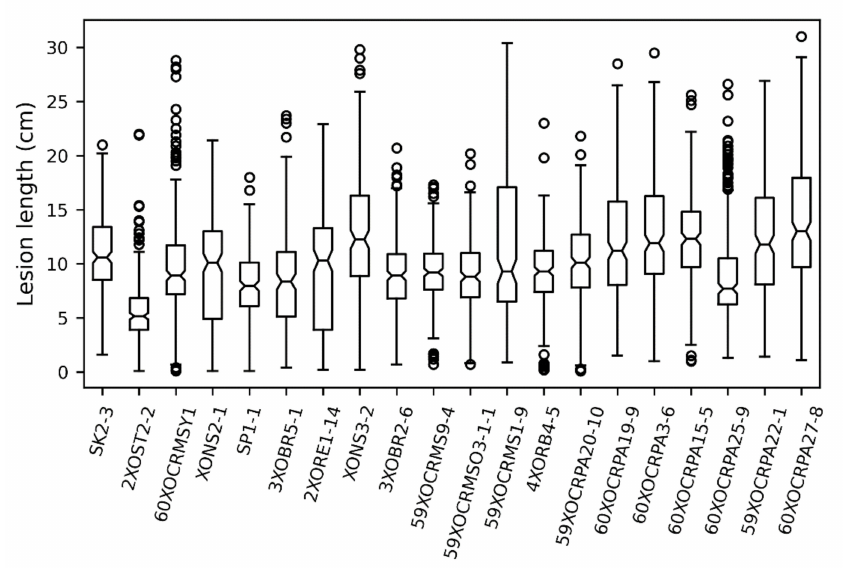
Figure 2. Leaf lesion length scores for BLB damage for rice panel cultivars across 20 focal Xoo isolates. Most Xoo isolates cause serious leaf